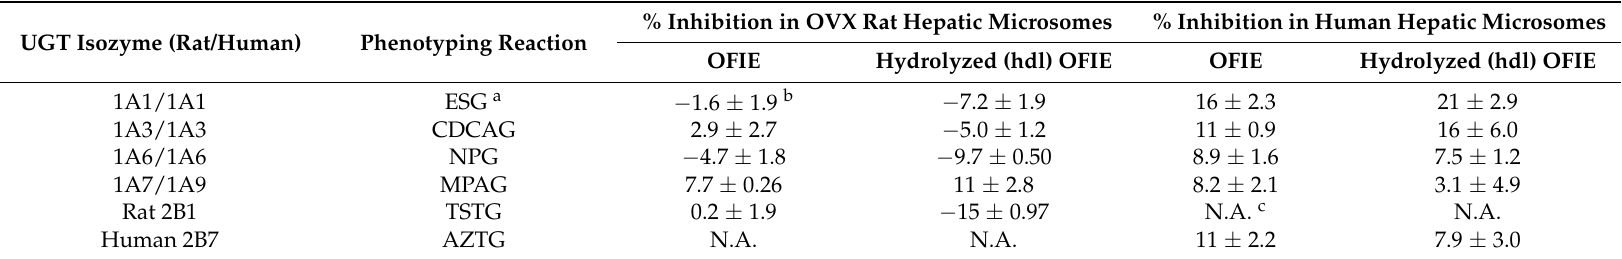
Table 2. The inhibitory effects of OFIE on the activities of UGTs in OVX rat and human liver microsomes. UGT Isozyme